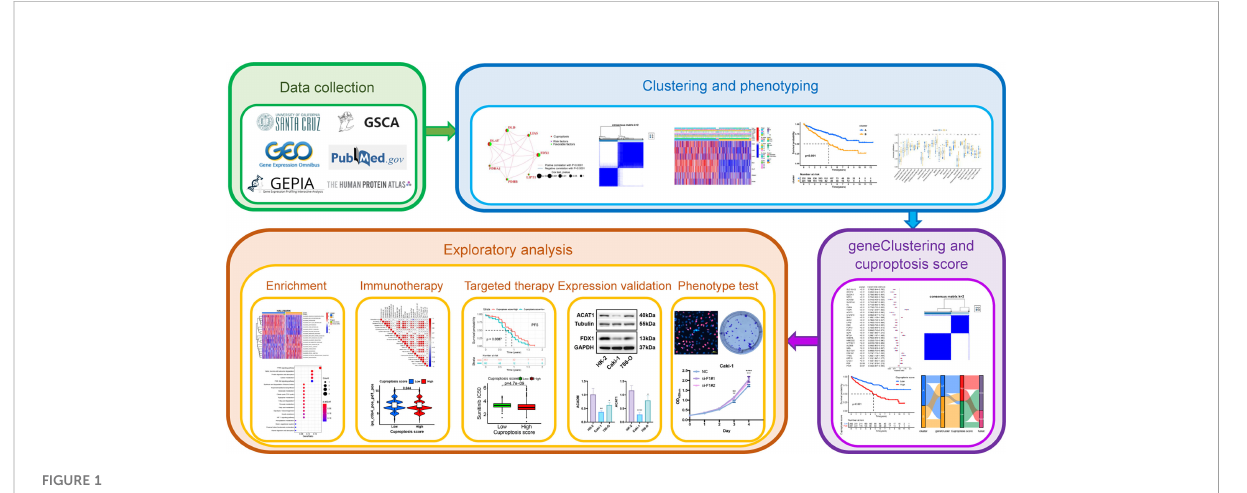
FIGURE 1 The fl owchat of this